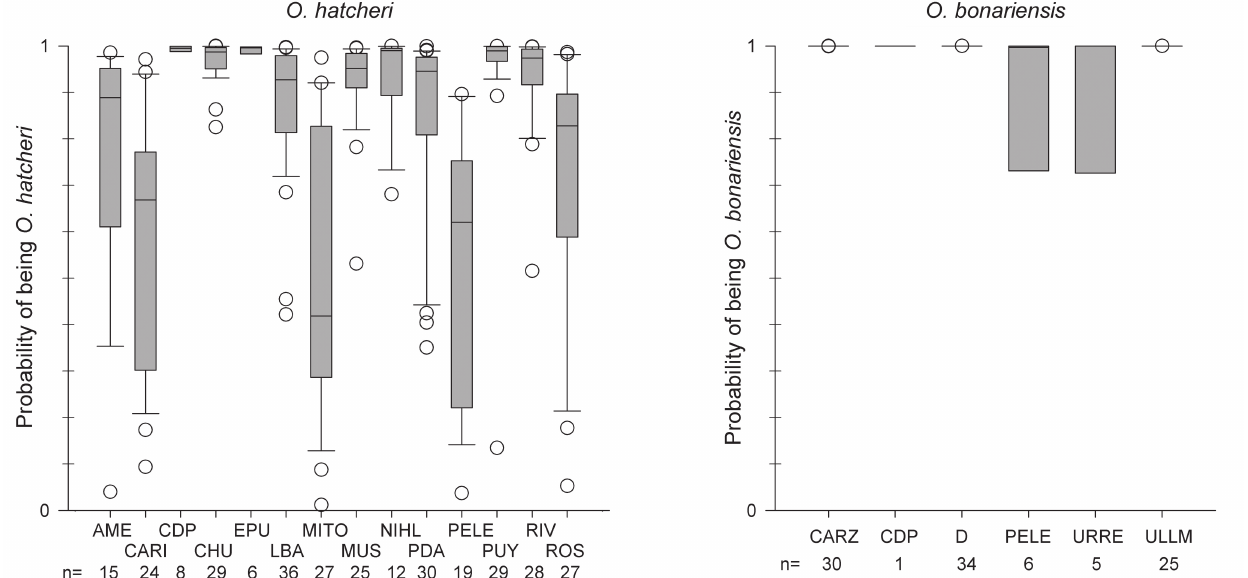
Fig. 6. Probability for taxonomically identified Odontesthes hatcheri individuals of being O. hatcheri (left) and probability of taxonomically identified O. bonariensis individuals of being O. bonariensis (right) . Number of fish, median, quartiles, and data outside 10 and 90 th percentile are indicated. Water bodies are named as in Fig. 1.